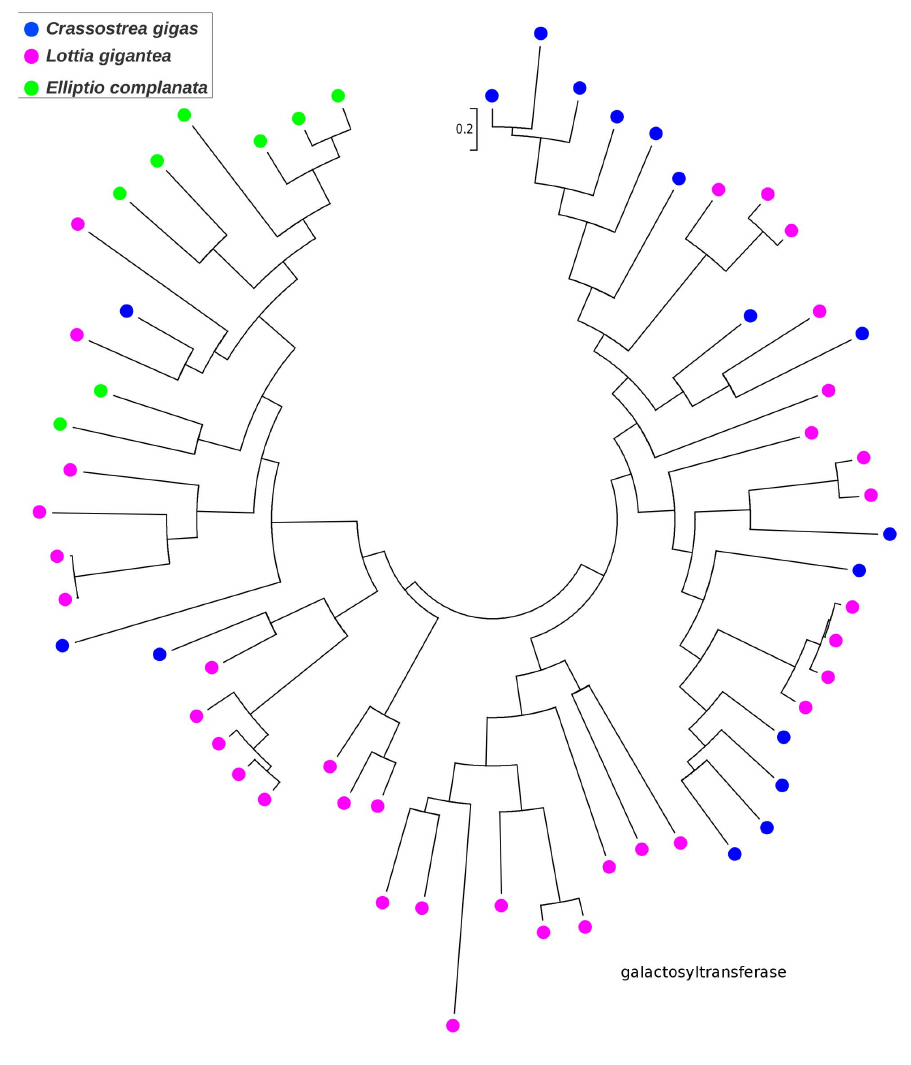
Figure 3. Gene tree of 1,3 beta-galactosyltransferase sequences from Elliptiocomplanata and two other molluscs suggesting lineage- specific diversification. Trees were rendered in MEGA5 [16] using maximum likelihood and the JTT amino-acid substitution matrix. Bootstrap support was not evaluated because no explicit phylogenetic hypothesis was tested. Multiple-sequence alignment with gene/contig names is provided in fasta format in the supplemental